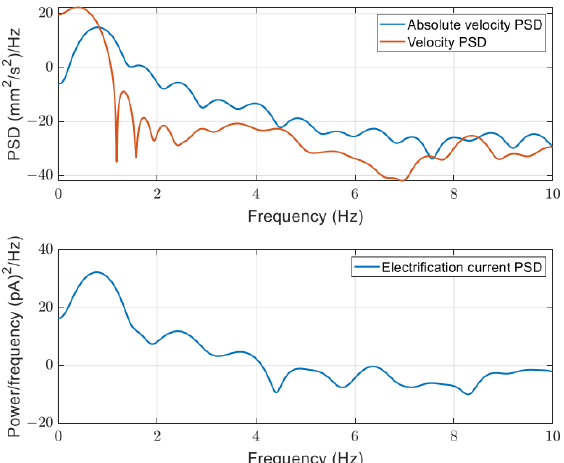
Figure 10. Power spectral densities estimated using Welch’s method of velocity and electrification current signals. The top picture also shows the absolute value of velocity to show coherence between the velocity and electrification current spectrum. The frequency of swinging is 0.4 Hz.